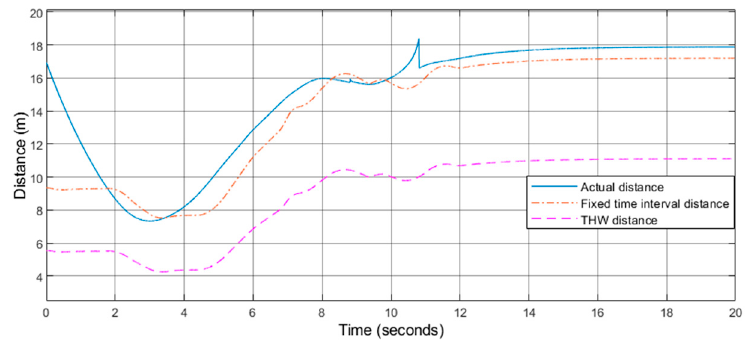
Figure 11. Distance image of front and rear vehicles.